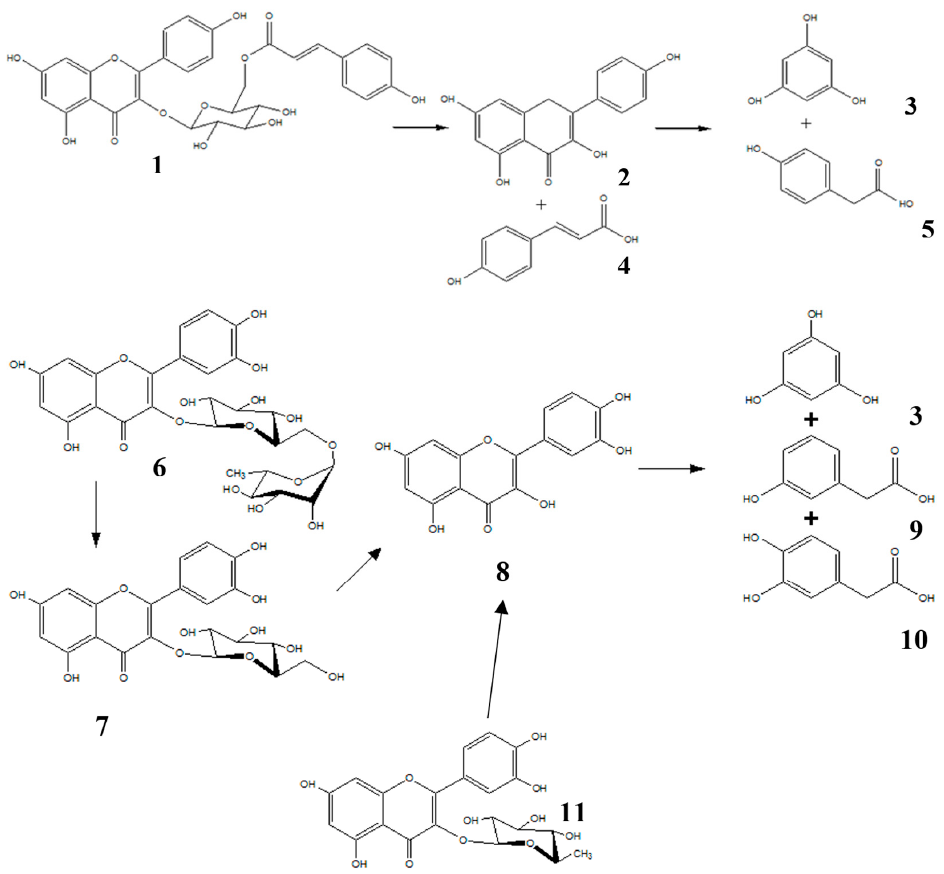
Figure 1. Flavonoid biotransformation process of tilliroside ( 1 ), rutin ( 6 ), quercetin glucoside ( 7 ), kaempferol ( 2 ), quercetin glucoside ( 8 ) and products obtained; phloroglucinol ( 3 ), coumaric acid ( 4 ), para-hidroxyphenyl acetic acid ( p -HPAA) ( 5 ), 3,4-dihydrophenylacetic acid (DOPAC) ( 10 ), meta-hydroxiphenyl acetic acid ( m -HPAA) ( 9 ), and quercitrin ( 11 ).